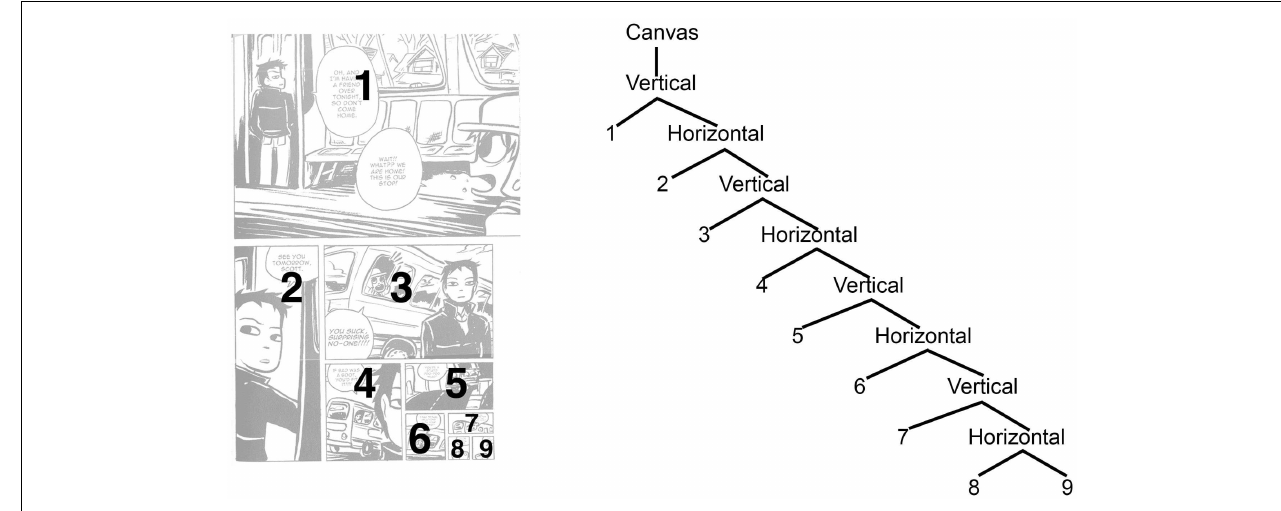
FIGURE 11 | Page from Scott Pilgrim vs.TheWorld with recursive embedding. Scott Pilgrim vs.TheWorld is © 2005 Bryan Lee O’Malley.